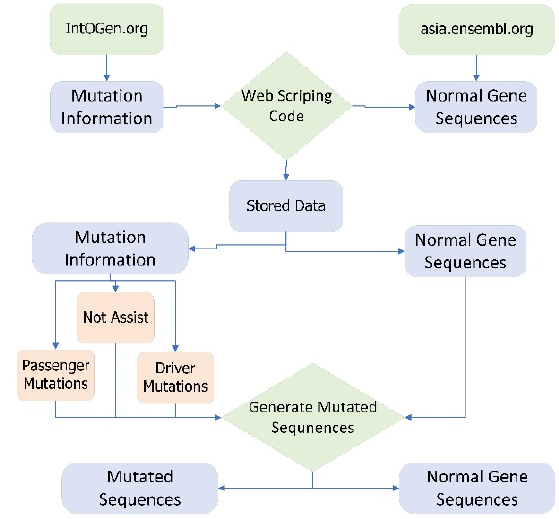
Figure 8. Data acquisition framework of Breast Adenocarcinoma. Table 5. Symbols of genes involved in breast adenocarcinoma. Gene Mutation Gene Mutation Gene